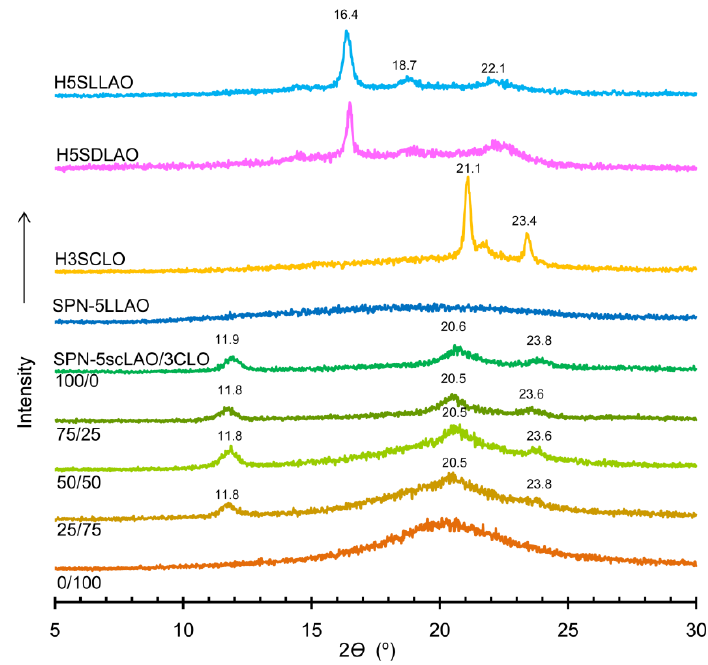
Figure 4. XRD patterns of H5SLLAO, H5SDLAO, H3SCLO, SPN-5LLAO and SPN-5scLAO/3CLOs (100/0, 75/25, 50/50, 25/75 and 0/100).